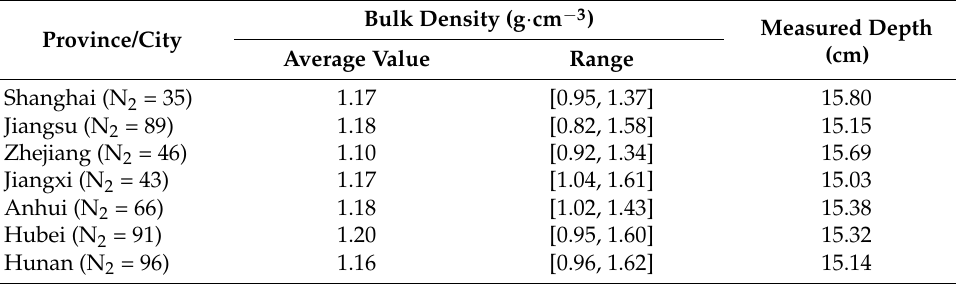
Table 2. Bulk density of paddy soil in the plough layer.